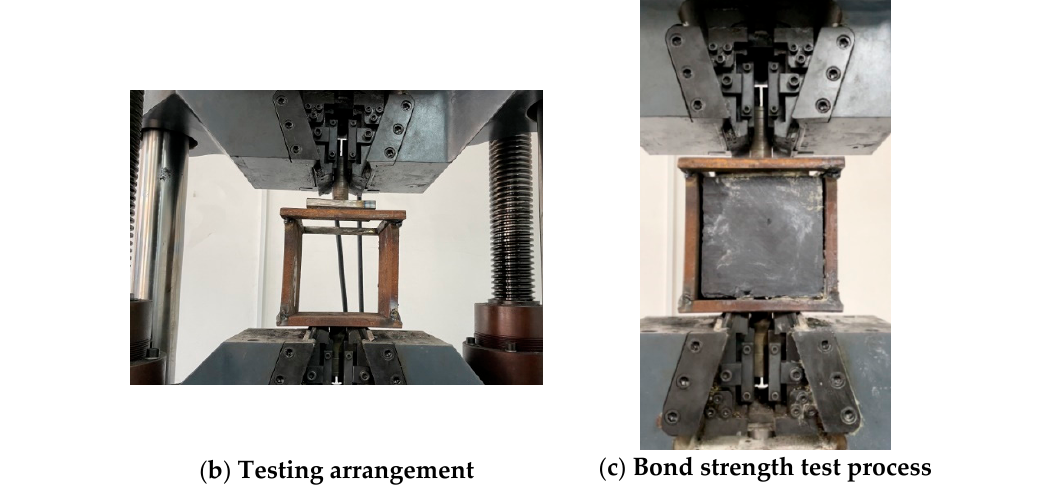
Figure 8. TSL–lignite bonding test.